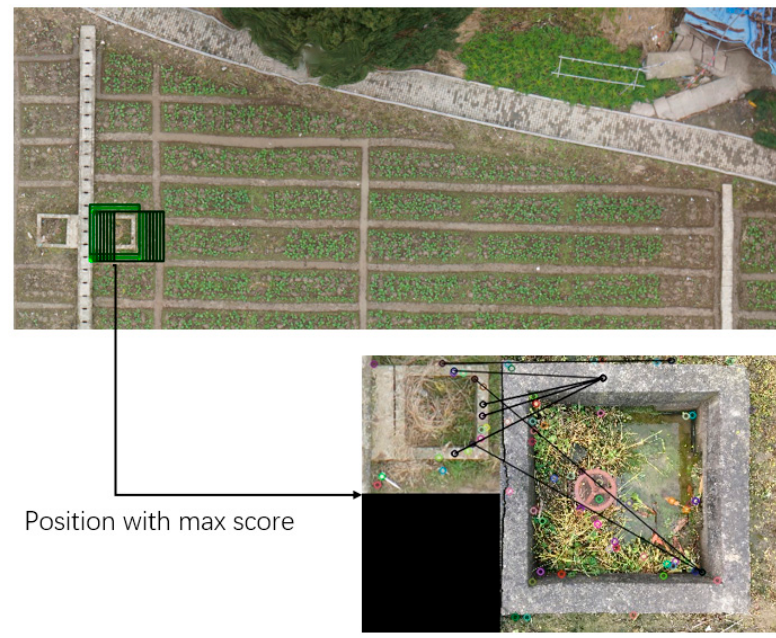
Figure 5. Travel through UAV image to find be best matched area.